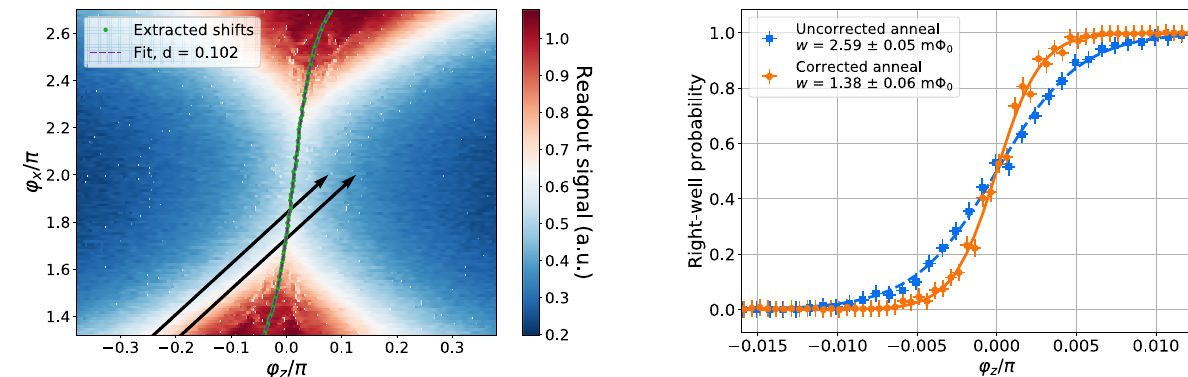
Fig. 4 S-curve without (blue) and with (orange) annealing-path correction. In the former, each data point is obtained by sweeping only φ x at fi xed φ z . In the latter, we added φ d ( φ x ) to φ z . Both anneals occur in 20 ns. The uncorrected anneal (squares) results in a width of 2.58 ± 0.05 m Φ 0 ( fi t, dashed line). Applying the correction (circles) narrows the s-curve by nearly 50% to 1.38 ± 0.06 m Φ 0 ( fi t, solid line). While both sets of data have been shifted and centered for ease of comparison, the corrected anneal should center the curve around the degeneracy point, which can be used to calibrate offsets in the z bias. Error bars show standard deviation and are calculated from binomial counting statistics, AWG voltage resolution, and quasistatic